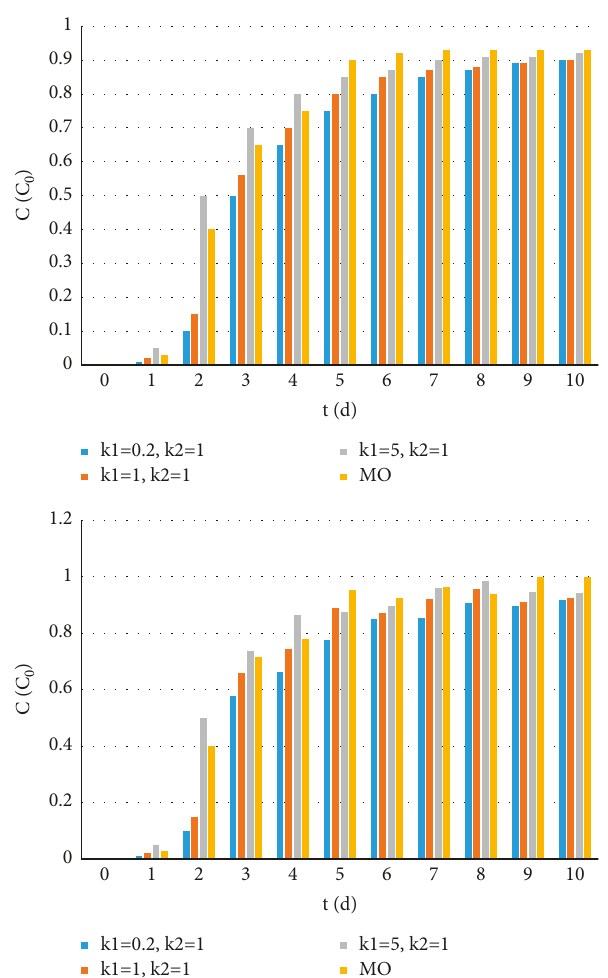
Figure 10: Effects of skin dispersity and porosity on radial pollutant transport. (a) A Effect of different dispersions on penetration curves under variable flow conditions. (b) The effect of different porosity on the